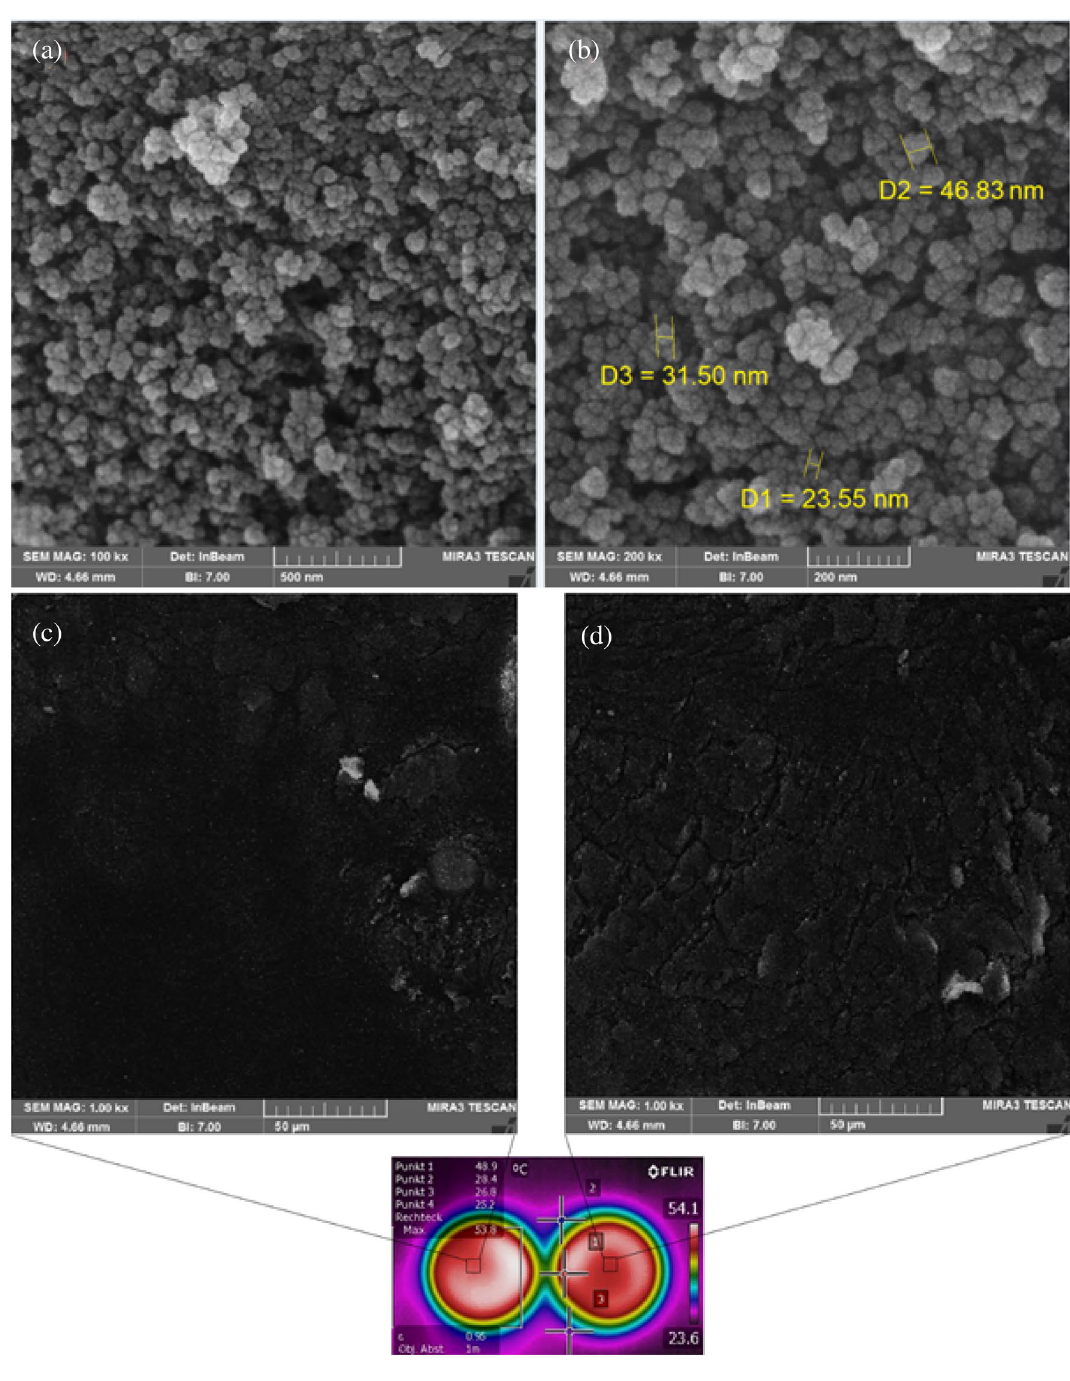
Figure 8. FESEM images of binder modified by fumed silica nanoparticles (FSN) at different magnifications. Average particle sizes of FSN are 33 nm. Uniformly and hexagonal structure shapes created with an average diameter of 100–300 nm. FESEM images of binder modified by FSN ( a - c ) unaged, and ( b - d ) after